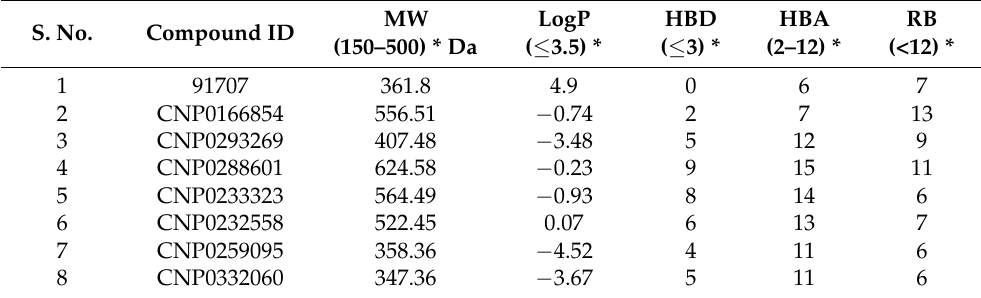
Table 2. Herbicide-likeness analysis of hit